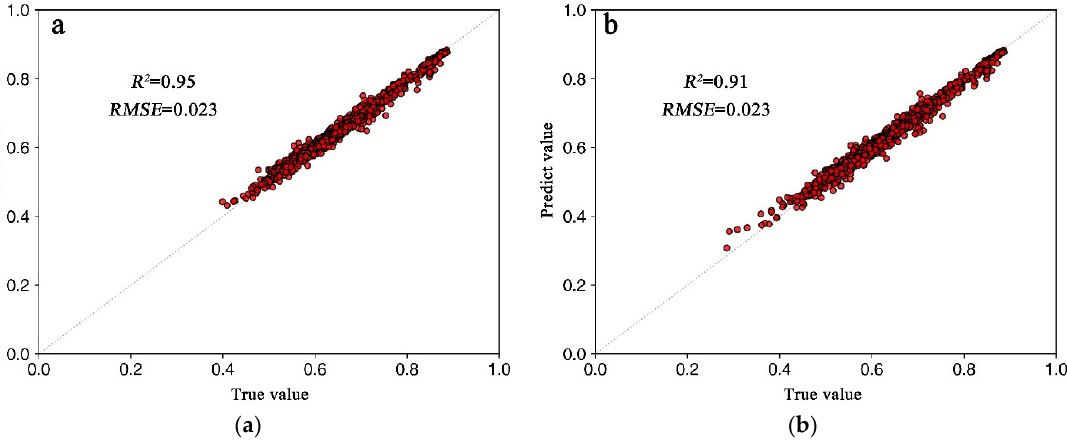
Figure 8. Performance of random forest regression on the responses of VG and VGT to precipitation and temperature in dry seasons: ( a ) VG and ( b ) VGT.